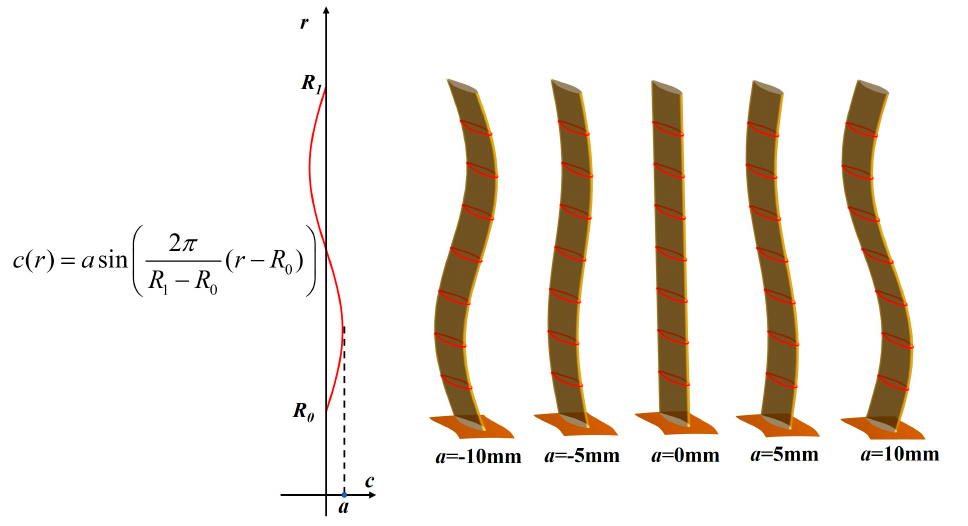
Figure 1. Guide vanes with different bending coefficients.